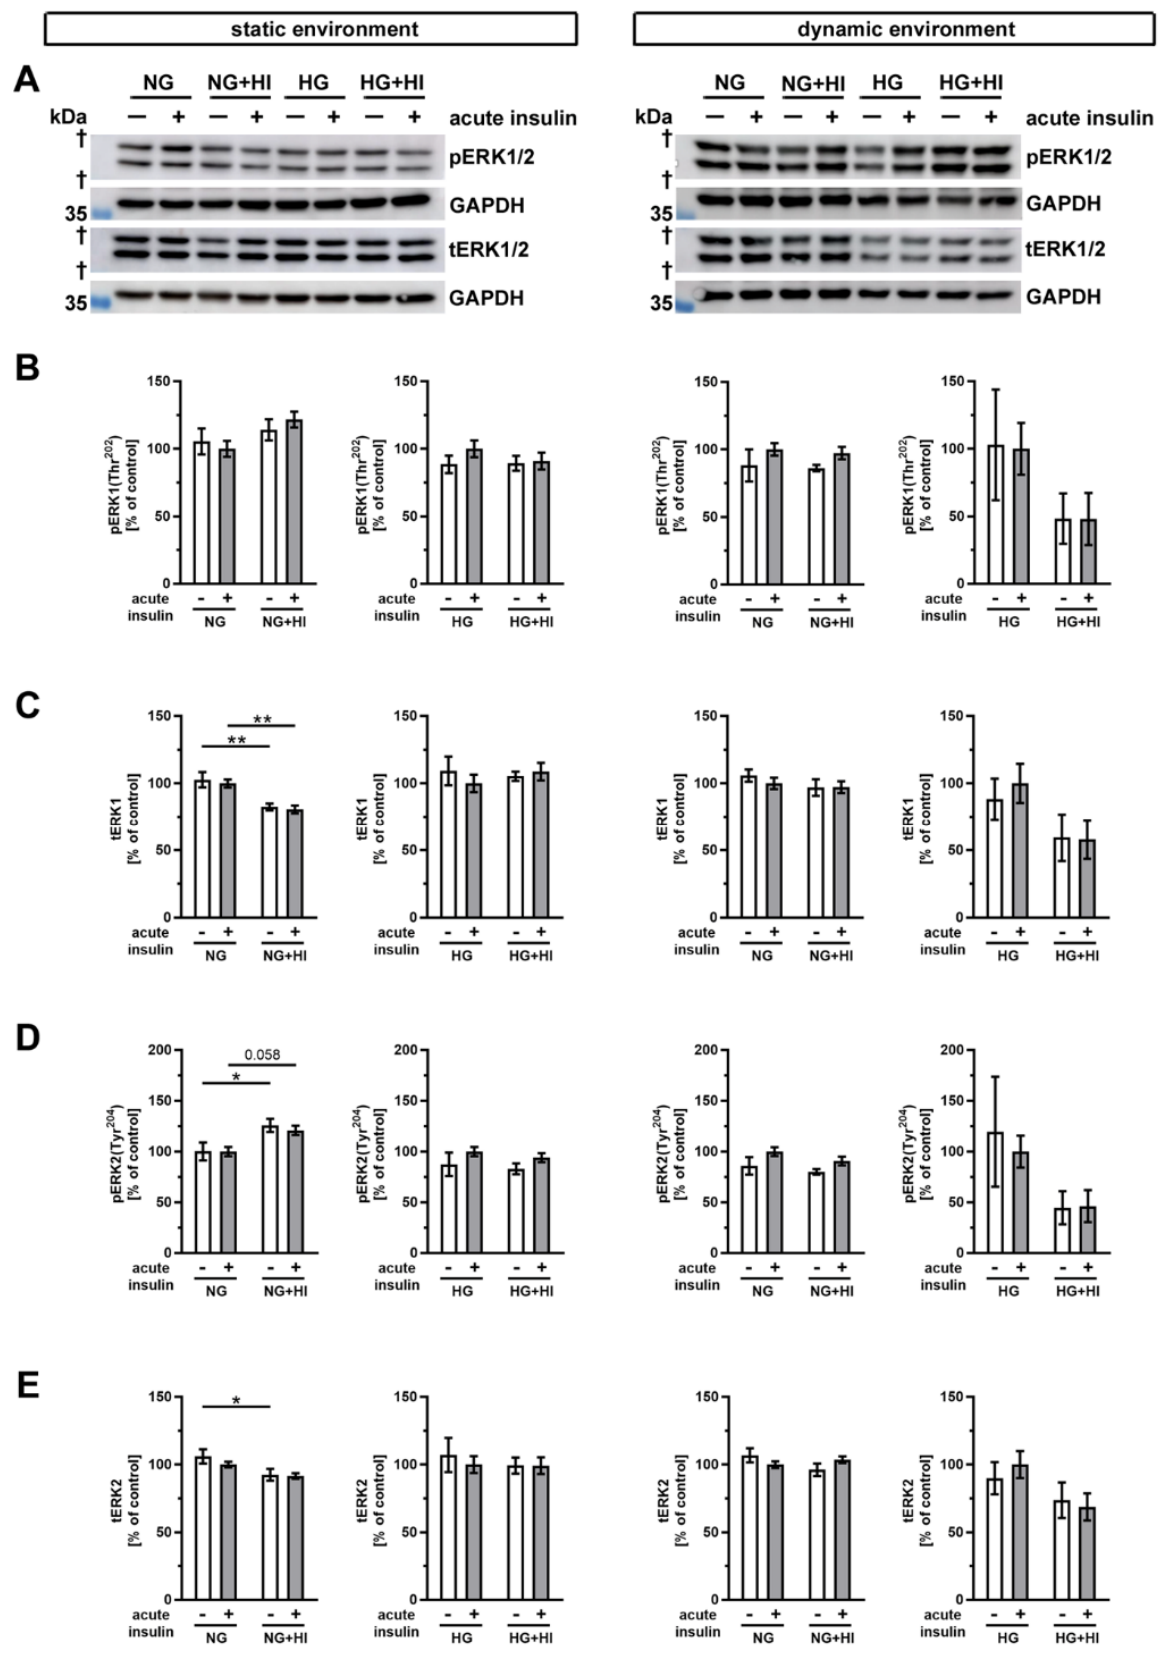
Figure 10. Activation of ERK1/2 signaling ( A ) Representative Western blot images demonstrate ERK1/2 phosphorylation as responses to acute insulin stimulation under diabetic cultivation conditions and its respective total ERK1/2 expression.